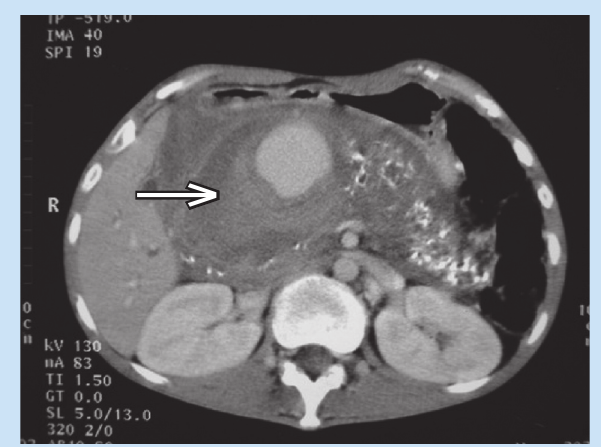
Fig. 1. Axial scan CT of upper abdomen demonstrating expansive mass in the pancreatic head (arrows) and extensive calcifications in pancreatic body and tail.